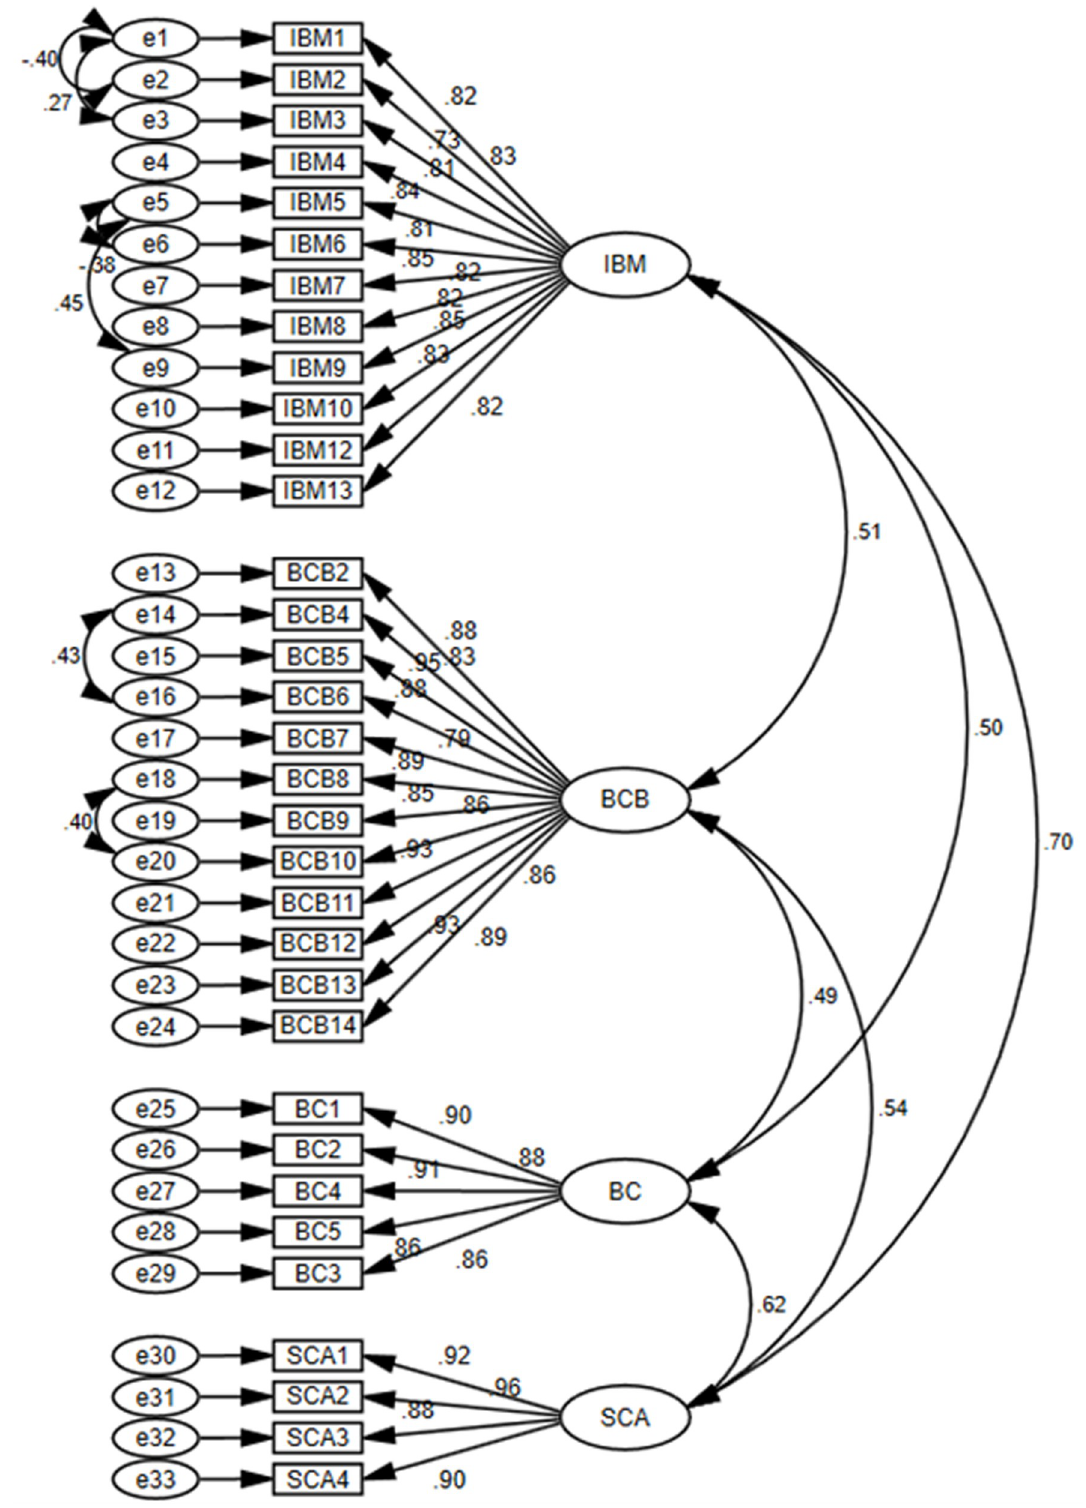
Fig 2. Confirmatory factor analysis ( χ 2 /df = 2.737; IFI = 0.944; TLI = 0.931; CFI = 0.944; RMSEA = .067; SRMR = .0372).